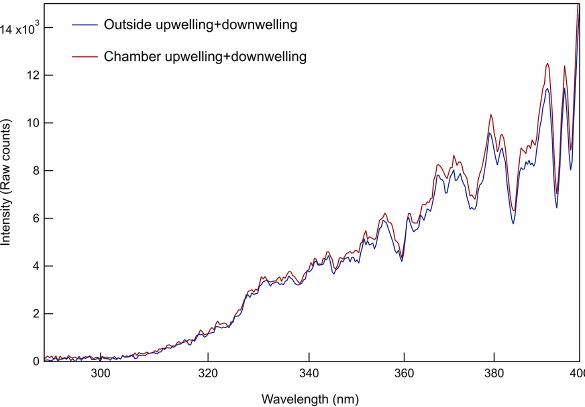
Figure 2. Comparison of spectral intensity measured just below one of the chambers (around point e in Fig. 1) and just outside of the chamber enclosure on a sunny